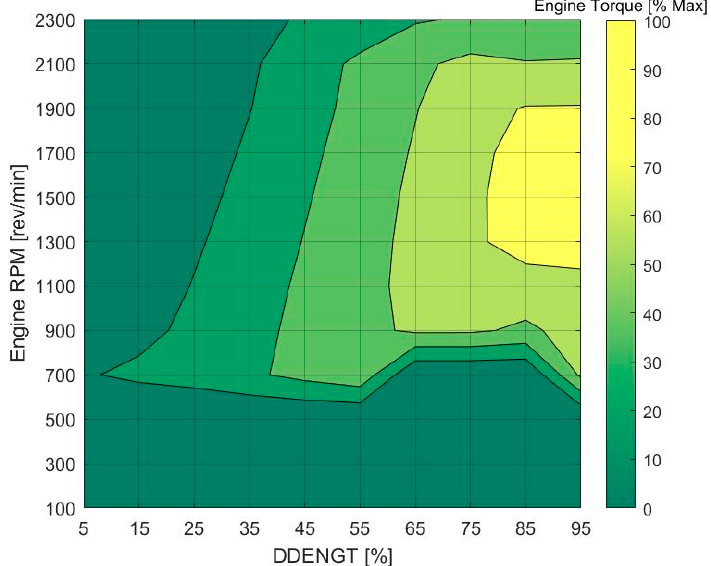
Figure 8. Torque map of APC engine.